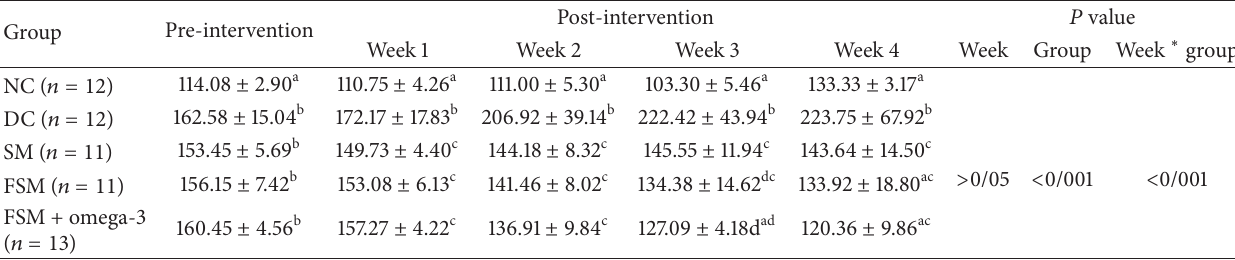
Table 1: Blood glucose change of each group fed with different